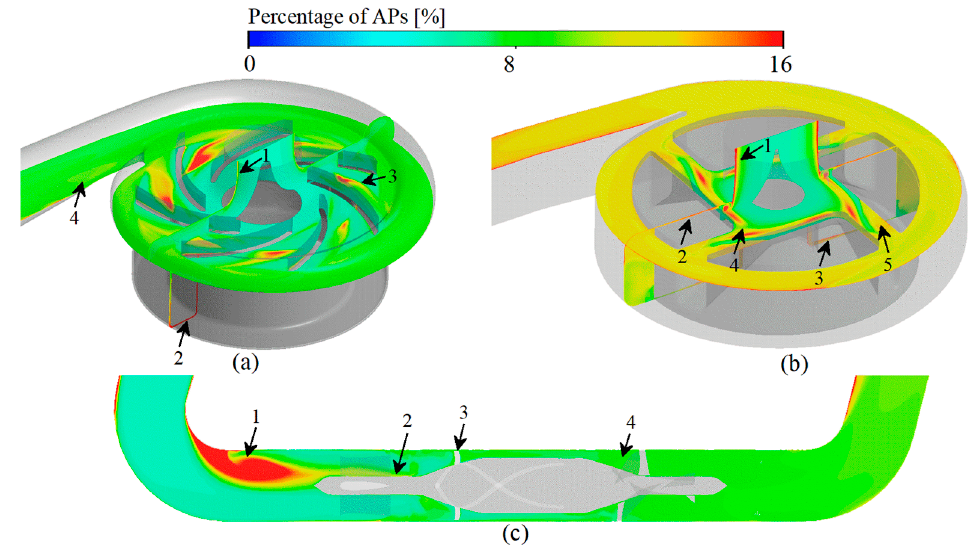
Figure 9. Activated platelets prediction of three studied VADs: ( a ) CH-VAD; ( b ) HVAD; ( c ) HMII.